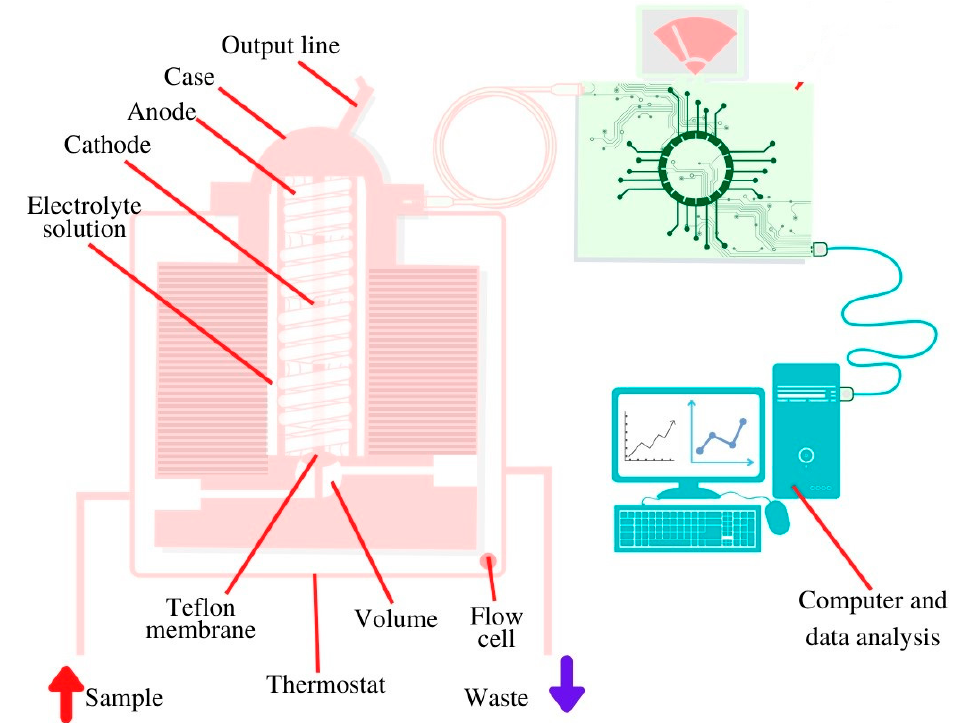
Figure 4. Schematic view of the salivary glucose biosensor inside installed in a 37 °C thermostat.